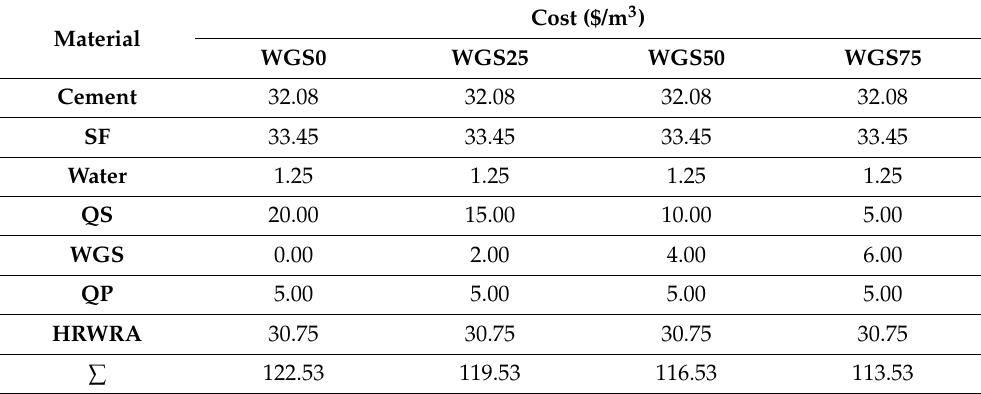
Table 4. Cost analysis details for each concrete mix.